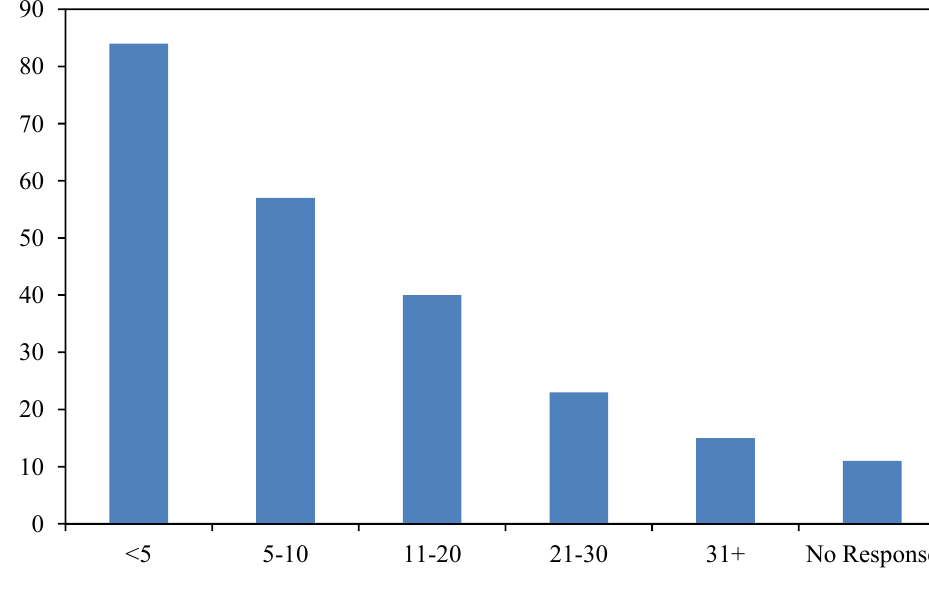
Figure 3. Graph of years in field distribution of respondents.